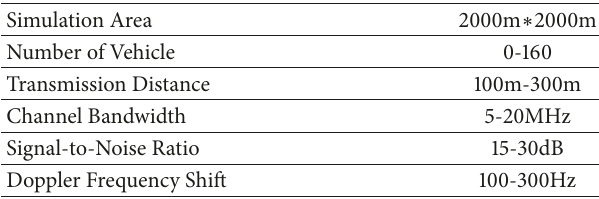
Table 1: Simulation parameter setting.